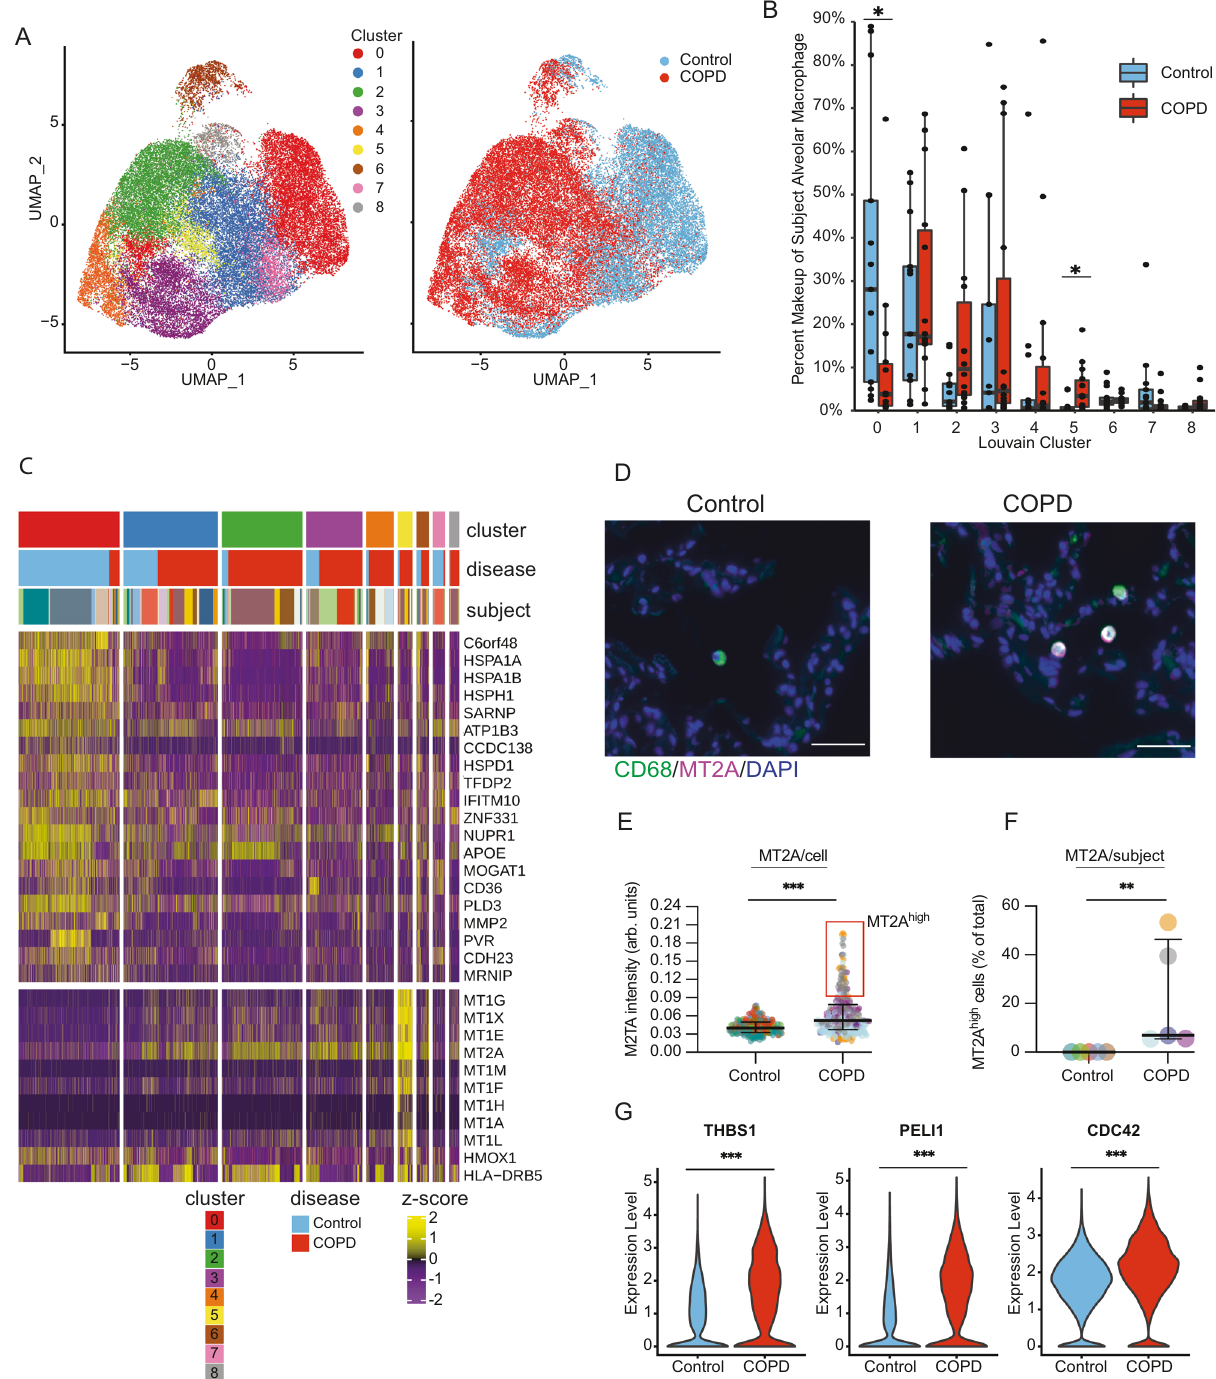
human lung tissue with COPD GWAS 53 . They colocalized single- nucleotide polymorphisms (SNPs) identi fi ed in COPD GWAS with local cis -regulation of CpG methylation and suggested that SNPs in close proximity to NUPR1 mediate local epigenetic regulation with relevance to COPD. Additionally, analyses by Hedstrom et al. suggest extracellular matrix in COPD may exert diverse effects including decreased NUPR1 expression 54 . Using three different in vitro models, including iPSC-derived AT2 cells grown at the air-liquid interface, we showed inhibition of NUPR1 mRNA increased susceptibility to CSE-mediated cell